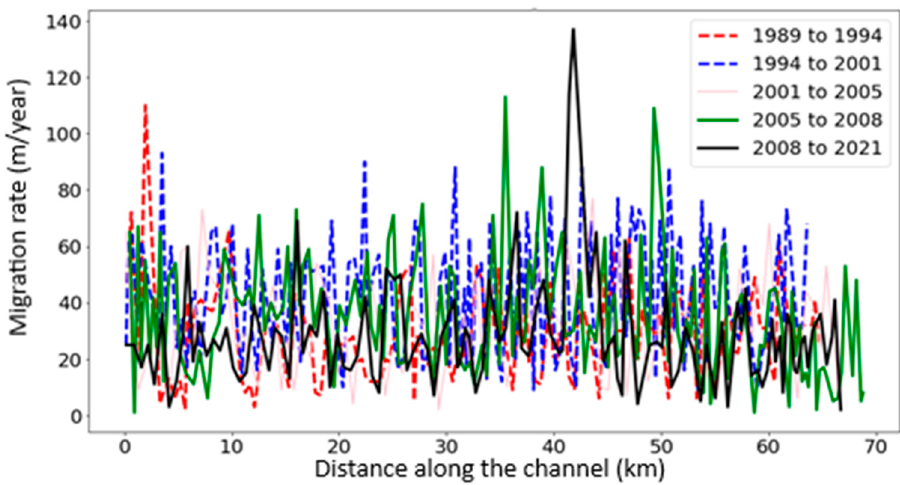
Figure 8. Centerline migration rates for the Deduru Oya.